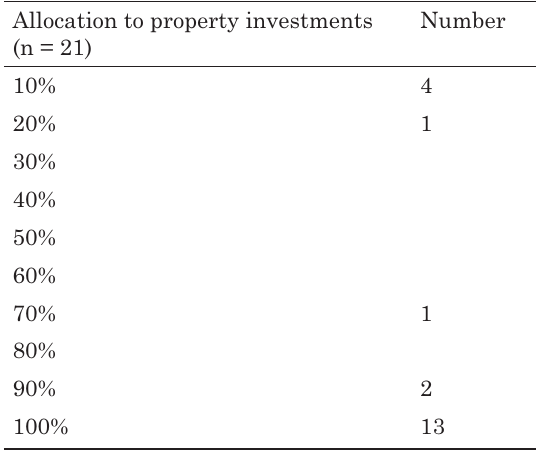
Table 3. Allocation to property investments Allocation to property